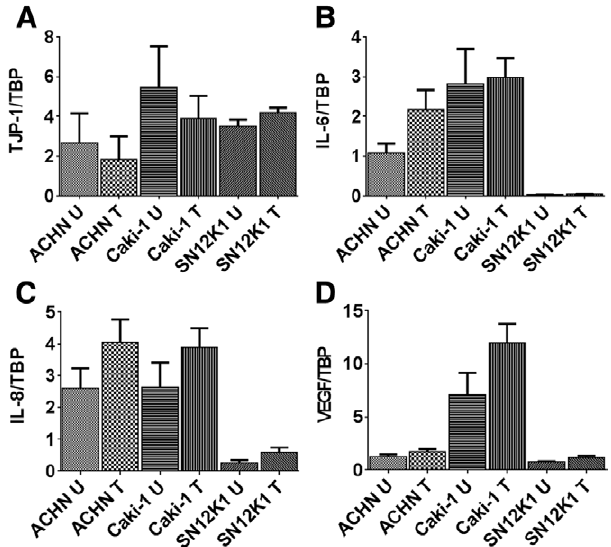
Figure 4. Lack of effect of maslinic acid on markers of RCC progression. Analysis of TJP-1 (A), the IL-6 (B), IL-8 (C), and VEGF (D) did not show any significant changes in response to maslinic acid. These results further confirm that the primary effect of maslinic acid on RCC cell lines is inhibition of proliferation. U: untreated; T: treated with maslinic